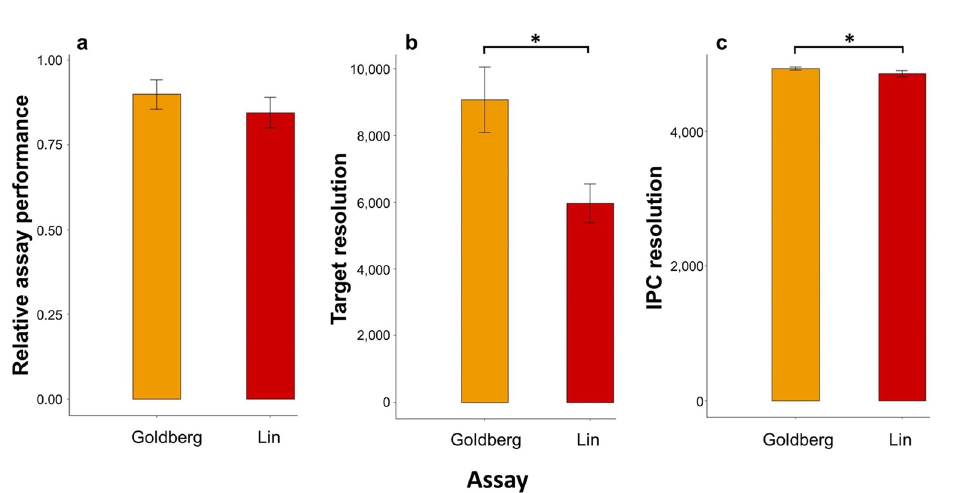
Figure 3. Results of the sensitivity tests of the Goldberg and Lin primer/probe assays using eDNA samples from natural water bodies (corresponding to Ranks 1–25 in Fig. 2). ( a ) Mean (± 1 s.e.m.) relative performance in bullfrog eDNA detection (in terms of eDNA concentration quantified per sample) and the mean (± 1 s.e.m.) ( b ) target and ( c ) IPC detection resolution. The detection resolution was calculated as the difference in fluorescence between positive and negative ddPCR